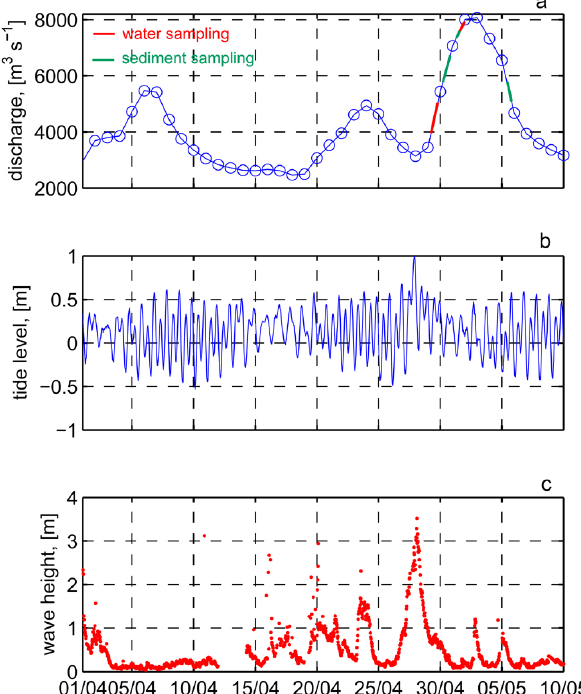
Fig. 3. Time-series data from 1 April through 10 May 2009. (a) River discharge during sampling in the prodelta. (b) Tide level. (c) Wave